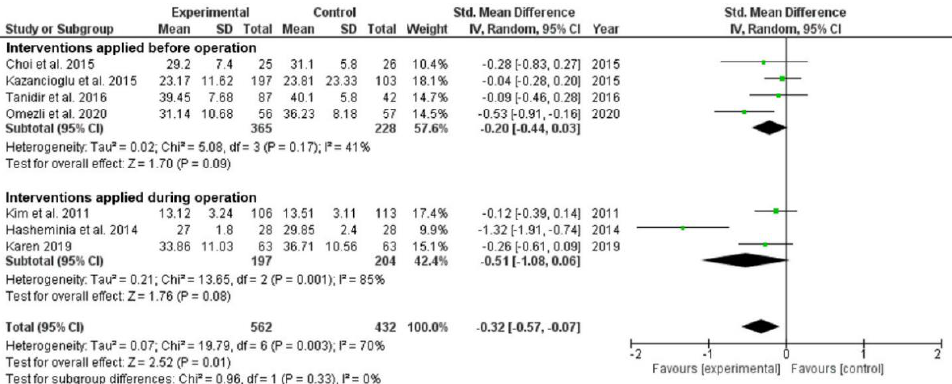
Figure 4. Forest plot of comparison: sub-group analyses—changes in anxiety level between groups with non-pharmacological interventions applied before and during third molar extraction [15,35,37,38,40,43,46].